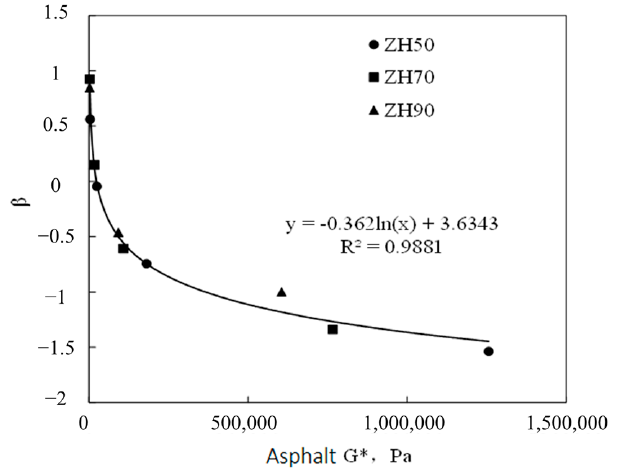
Figure 5. Relationship between asphalt modulus and shape parameter β .